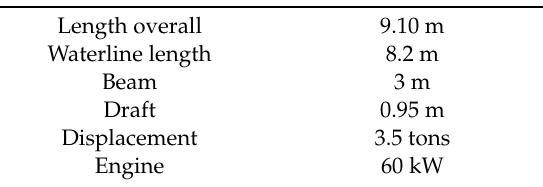
Table 1. Conrad-900 main data.